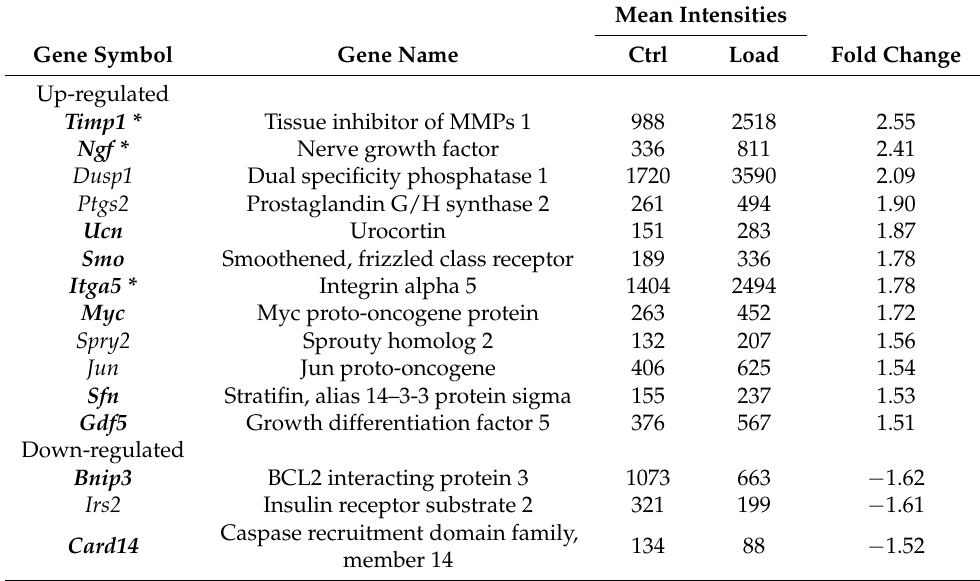
Table 2. Mean microarray expression levels of the genes recorded in the PANTHER “Negative Regulation of Apoptotic Process” category in loaded and non-loaded Ext1 gt/gt samples. Mean Intensities Gene Symbol Gene Name Ctrl Load Fold